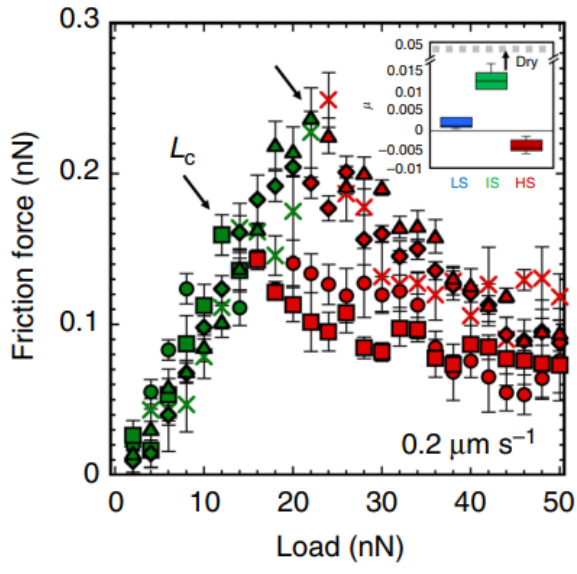
Figure 3: Friction between calcite and an AFM tip as a function of load in CaCl solutions at sliding speed of 0.2 µm/s (after Diao and 2 Espinosa-Marzal Figure 3 : Friction between calcite and an AFM tip as a function of load in CaCl 2 solutions at sliding speed of 0.2 µm/s (after Diao and Espinosa-Marzal 2018)